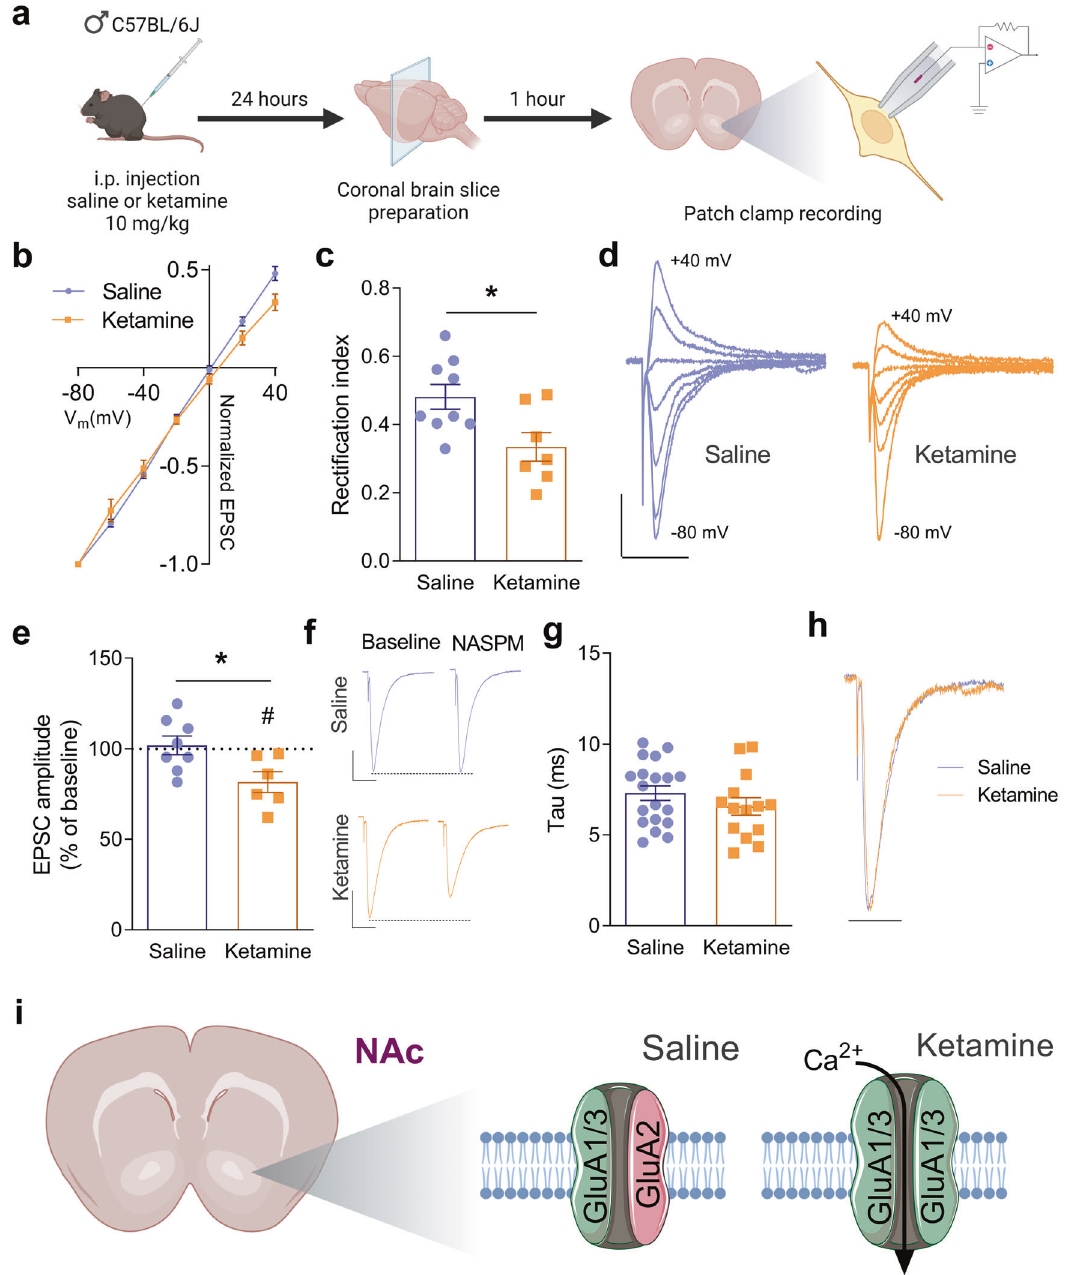
Fig. 2 Ketamine promotes the insertion of CP-AMPARs at glutamatergic synapses on NAc SPNs. a Schema illustrating the experimental design. b I/V relationships of AMPAR-EPSCs amplitude normalized by − 80mV in NAc SPNs from saline- and ketamine-treated mice. c Recti fi cation index from the neurons in ( a ) Saline: 0.481 ± 0.04 ( n = 9 neurons from 5 mice), Ketamine: 0.335 ± 0.04 ( n = 7 neurons from 3 mice). * P = 0.0197 unpaired t -test. d Example traces of AMPAR-EPSCs recorded at holding potentials between − 80 mV and + 40 mV with 20 mV increments in a NAc SPN from a saline-treated mouse and in a NAc SPN from a ketamine-treated mouse. Scale bars represent 100 pA and 20 ms for both neurons. e Effect of bath application of NASPM (25 μ M); % of baseline in saline-treated mice: 101.9 ± 5.2 ( n = 8 neurons from 4 mice), and in ketamine-treated mice: 81.6 ± 5.7 ( n = 6 neurons from 4 mice), * P = 0.0228 unpaired t -test. # P = 0.0237 paired t -test. f Example traces of AMPAR-EPSCs before (baseline) and during the application of NASPM in the perfusion solution in a NAc SPN from a saline- treated mouse and in a NAc SPN from a ketamine-treated mouse. Scale bars represent 100 pA and 20 ms for both neurons. g AMPAR-EPSC tau (ms) in saline-treated mice: 7.3 ± 0.4 ( n = 19 neurons from 5 mice), and in ketamine-treated mice: 6.57 ± 0.5 ( n = 14 neurons from 4 mice), P = 0.2499 unpaired t -test. h Superimposed AMPAR-EPSCs traces illustrating similar kinetics in a NAc SPN from a ketamine-treated mouse and in a NAc SPN from a saline-treated mouse. Scale bar represents 20 ms for both neurons. i Schema summarizing the effect of ketamine on the involvement of GluA2 in synaptic AMPARs in NAc